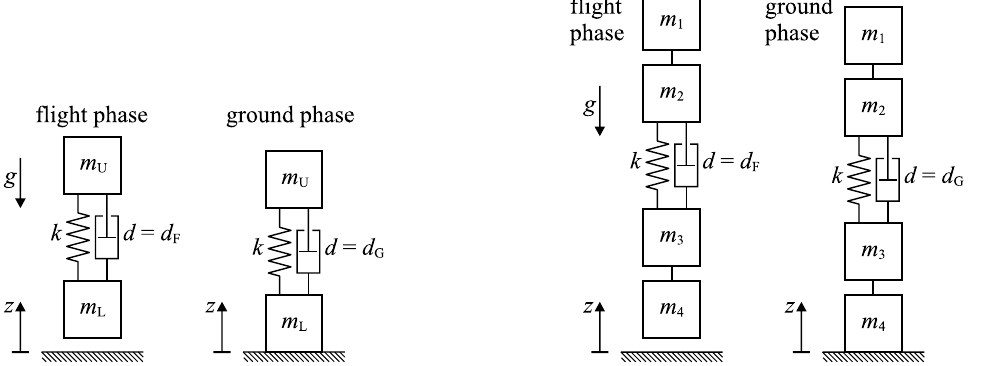
Figure 1. The unconstrained hopping model in the flight and the ground phases [24] ( left panel); the constrained model in the flight and the ground phases ( right